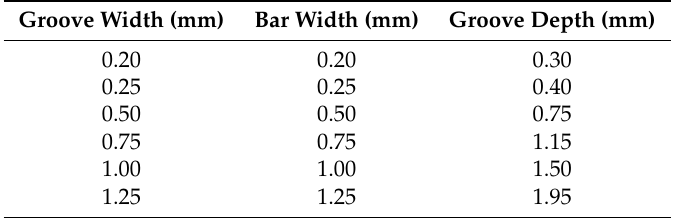
Table 3. Dimensions of grooves used in the gratings orientation